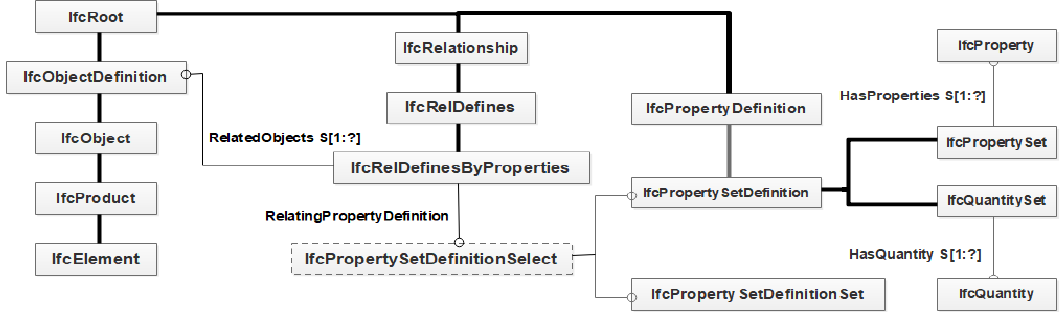
Figure 2. Express-G expression model of component attributes based on IFC.